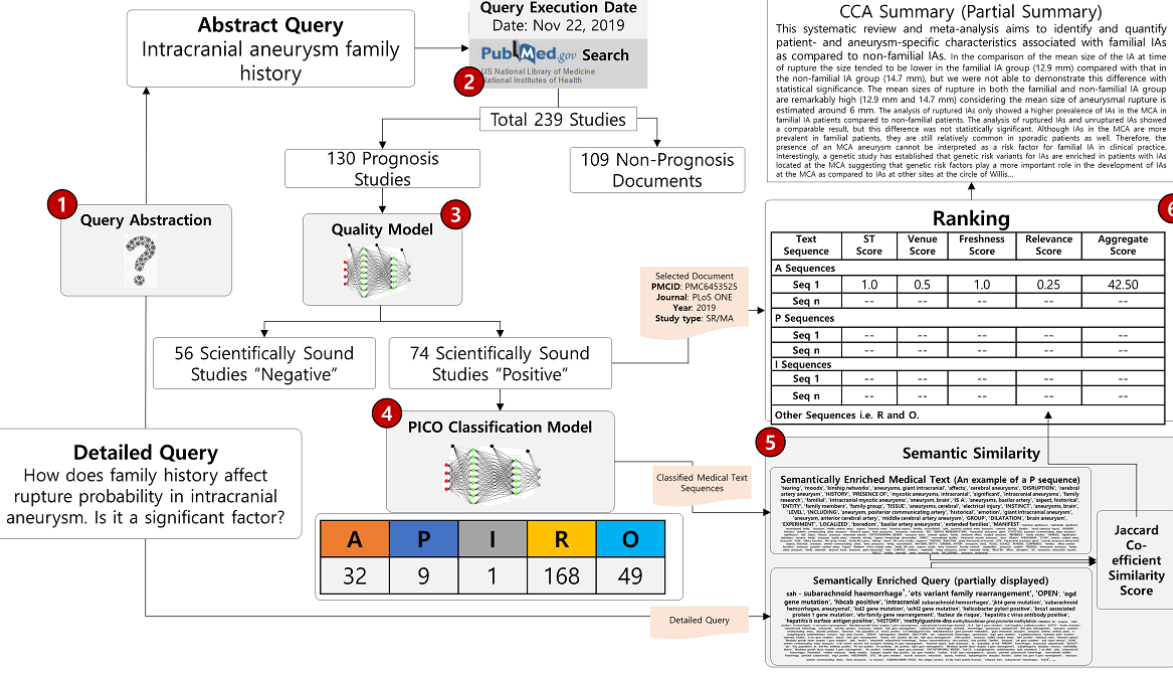
Figure 4. Step-by-step scenario of query execution, retrieval of documents, quality checking, clinical context-aware (CCA) classification, semantic similarity, ranking, and summary creation. A: Aim; P: Population/Patients/Problem; I: Intervention; R: Results; O: Outcome; PICO: Patient/Problem, Intervention, Comparison,